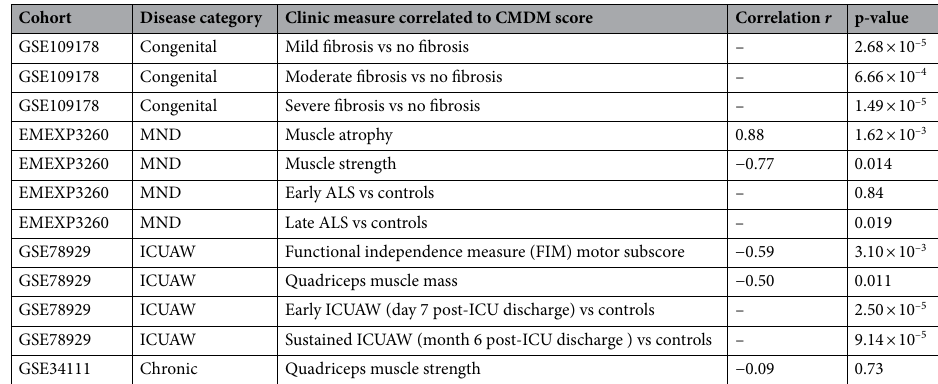
Table 3. Associations of common muscle disease module (CMDM) scores with clinical and histological measures of disease severity.